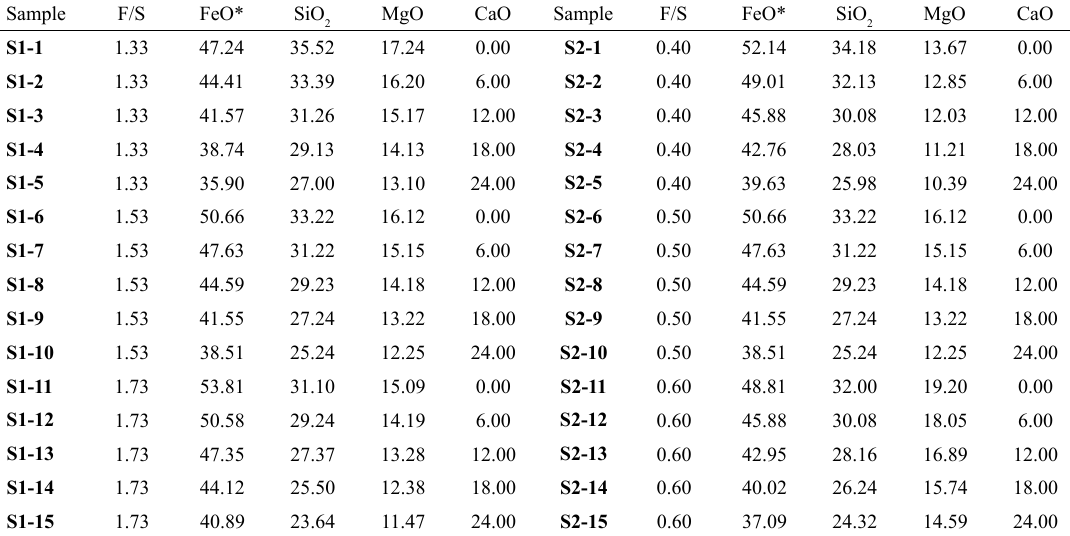
Figure 1. Schematic diagram of the Hot Stage Microscope (a) and silhouette photographs (b-e) of samples during the smelting process. Table 1. Compositions of samples for designed experiments (wt.